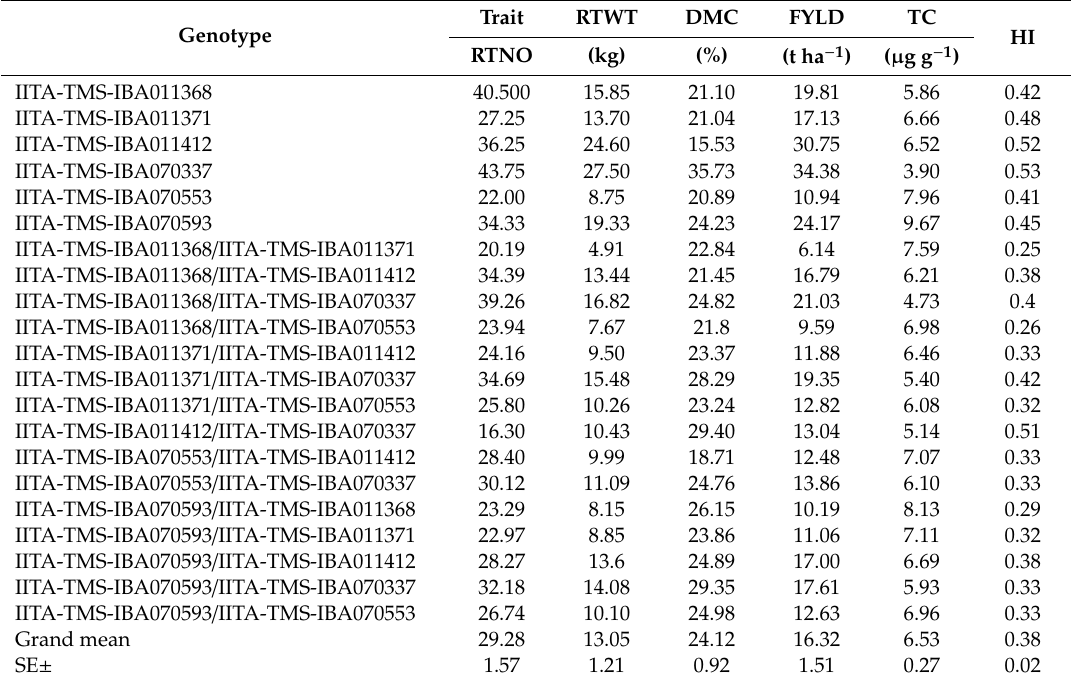
Table 4. Mean performance of parents and F1 hybrids for studied